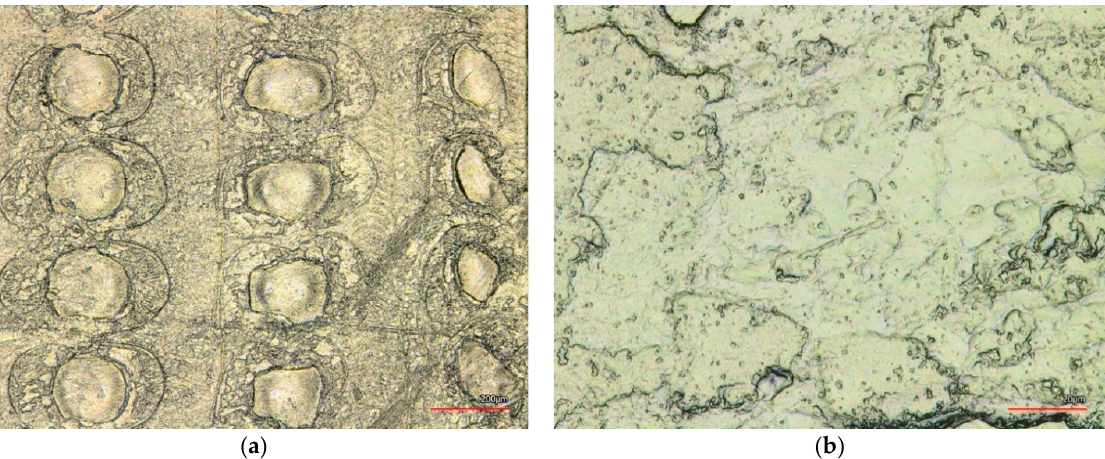
Figure 14. Confocal Laser Scanning Microscope (CLSM) images of MED610 object, sample—29. Scale bars indicate: ( a ) 200 μ m ( b ) 20 μ m